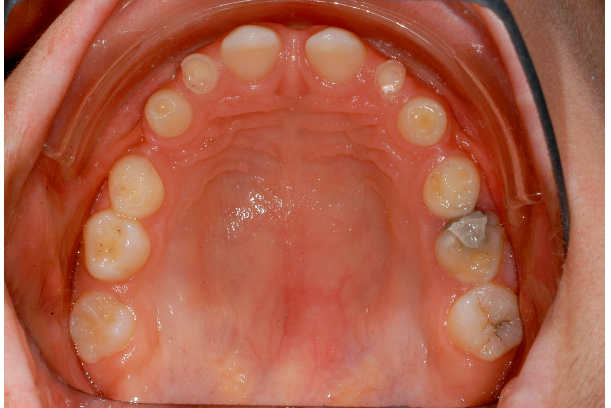
Figure 8. Intraoral situation: oligodontia, microdontia of teeth 11 and 21.